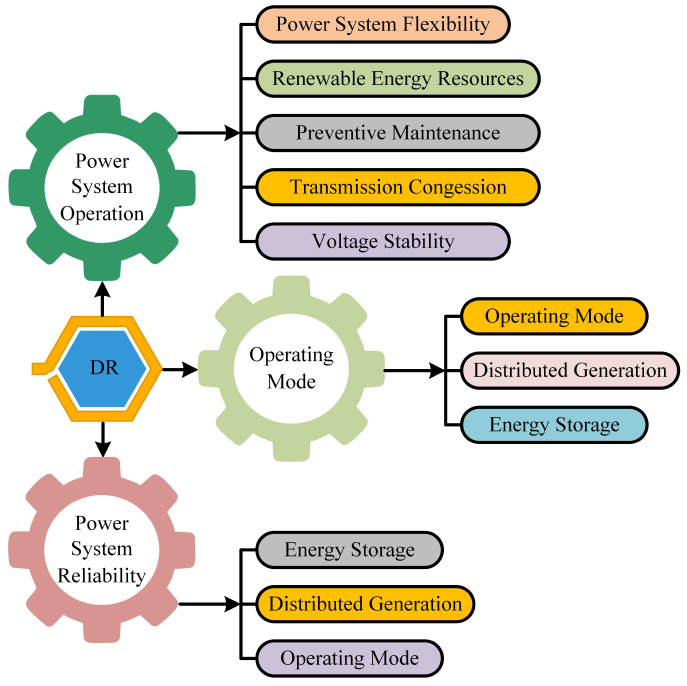
Figure 6. DR integration with power